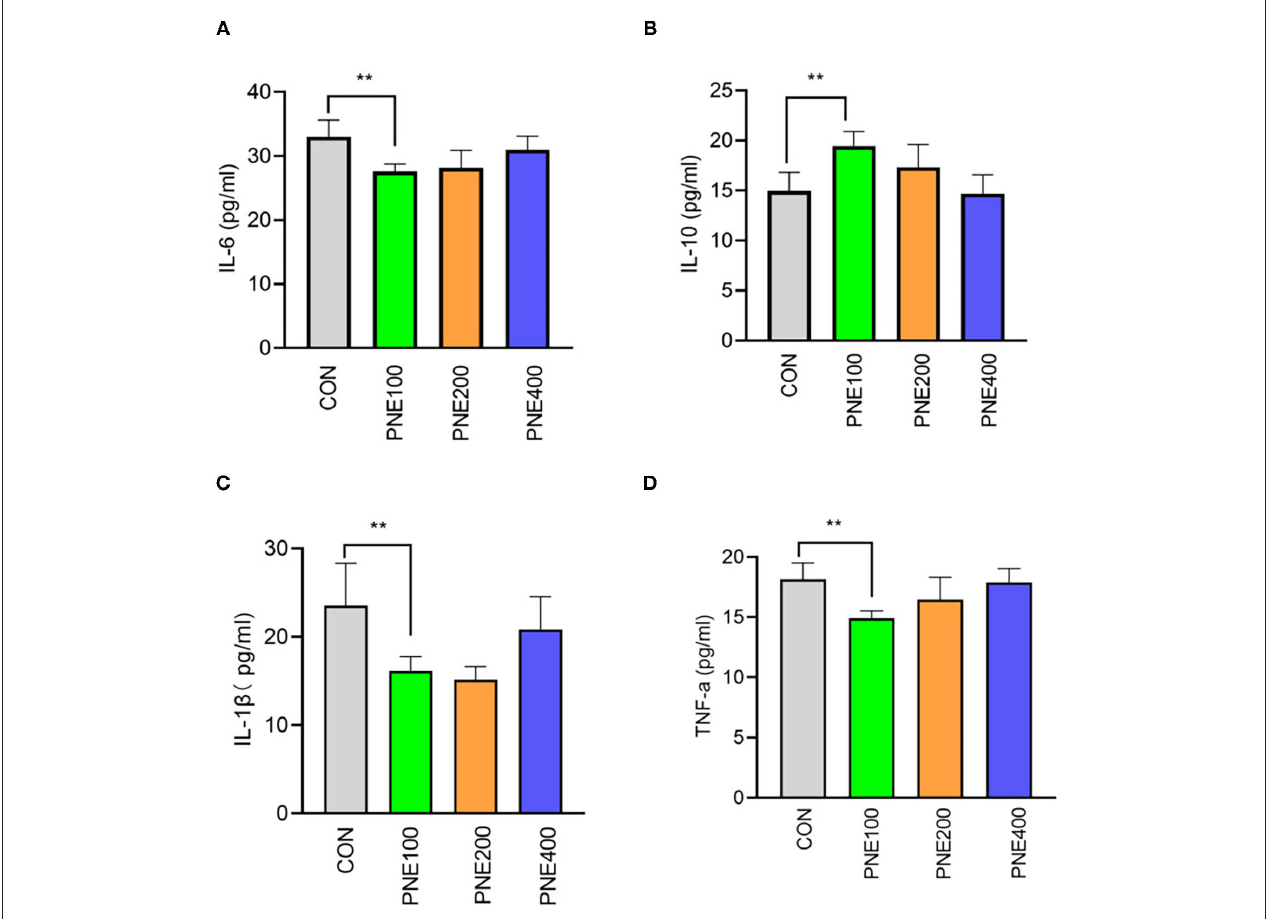
FIGURE 4 | Effect of pine needle extract (PNE) supplementation on serum inflammatory cytokines IL-6 (A) , IL-10 (B) , IL-1 β (C) , and TNF- α (D) of laying hens. IL-6, interleukin 6; IL-10, interleukin-10; IL-1 β , interleukin-1 β ; TNF- α , tumor necrosis factor- α . Asterisks denote significant differences (** p ≤ 0.01), n = 6 per group, data are expressed as means ±